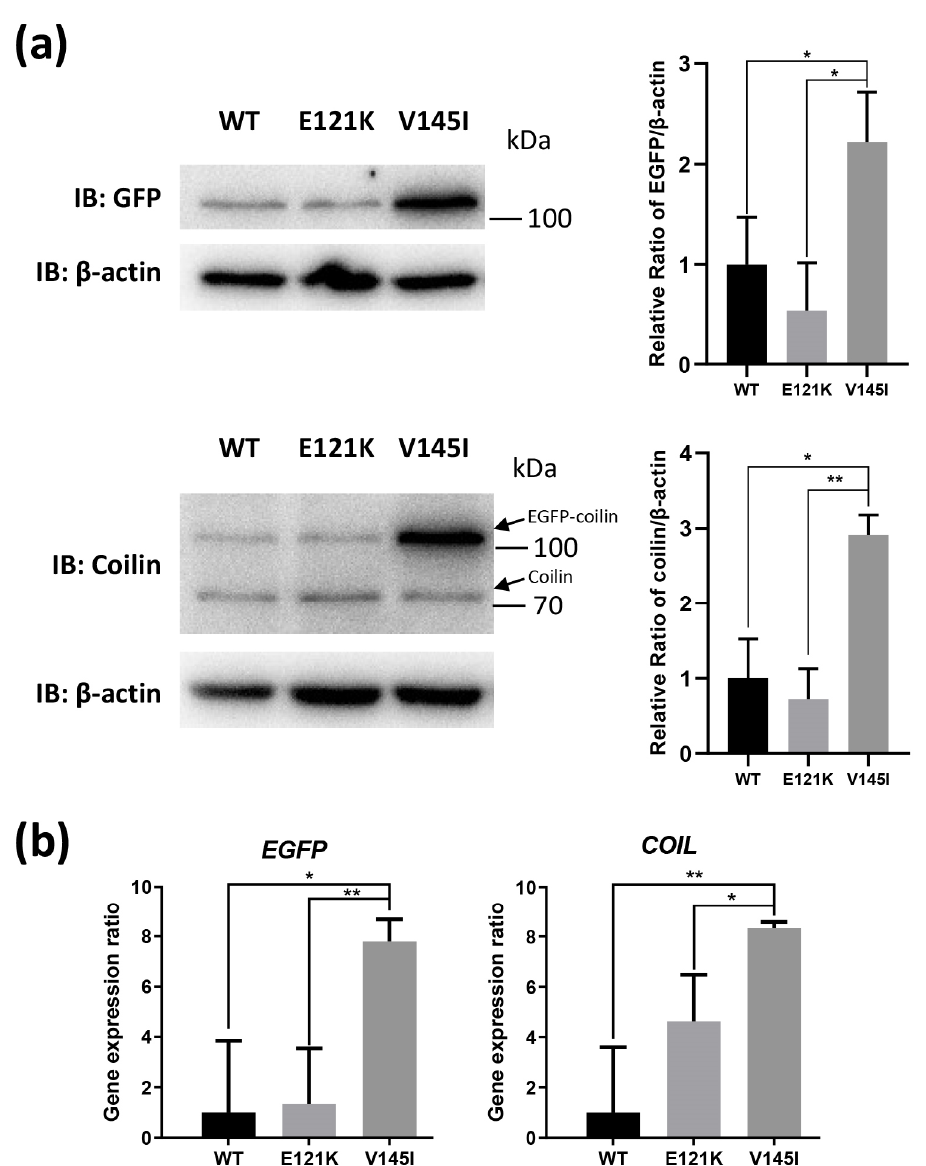
Figure 5. E ff ects of coilin SNP variants on coilin protein and gene expression. ( a ) Immunoblotting of coilin WT and SNP variant cells probed with GFP (sc-9996; EGFP-coilin ≈ 110 kDa) or coilin (sc-55594; coilin ≈ 80 kDa) antibody; β -actin (A5441; ≈ 42 kDa) was served as an internal loading control (see Figure S4 for full blot). Figures are representative of three independent experiments with similar expression trends. ( b ) Gene expression of coilin in the three cell lines was analyzed using RT-qPCR; the ATCB gene was used as an internal reference to normalize gene expression. * p ≤ 0.05; ** p ≤ 0.01.